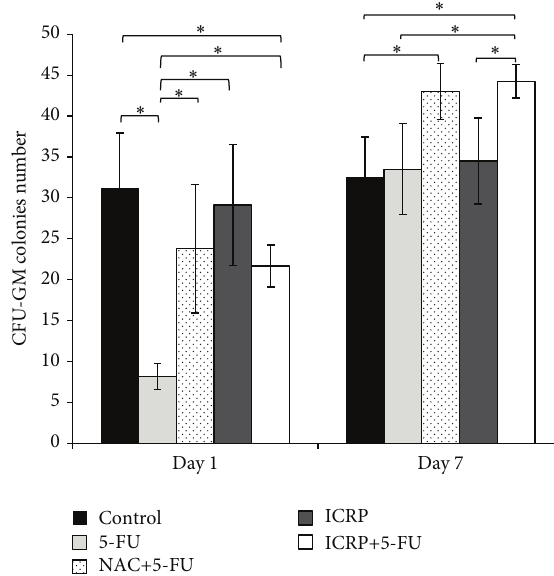
Figure 2: Colony forming units-granulocyte/macrophage (CFU- GM) assay: BM cells from both femurs and tibias were obtained on day 1 and day 7 from treated mice. Subsequently, BM cells were grown mouse methylcellulose complete media in a 5% CO 2 incubator for 14 days and colonies were counted ∗ (𝑃 < 0.05 ) ( 𝑛 = 3